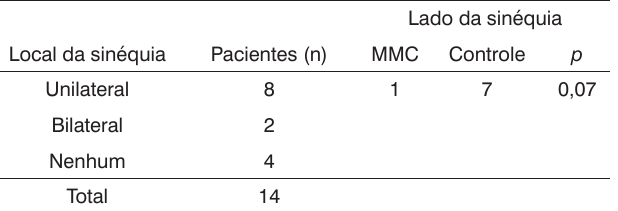
Tabela 4. Localização das sinéquias em 14